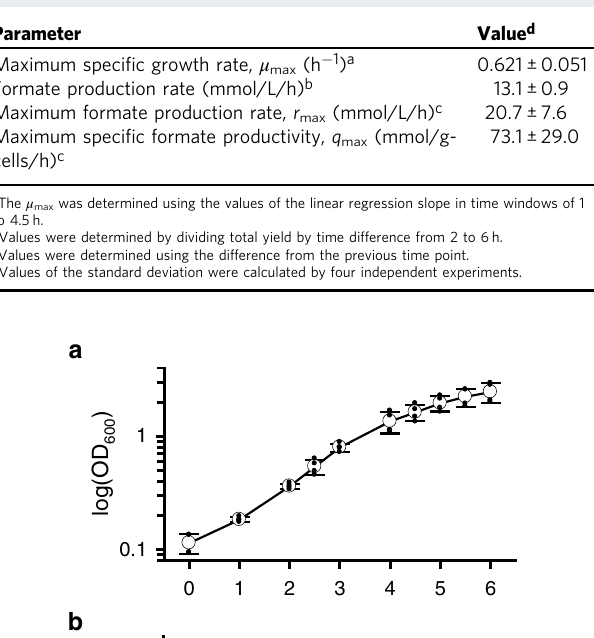
Table 2 Bioreactor parameters of T. onnurineus BCF13.